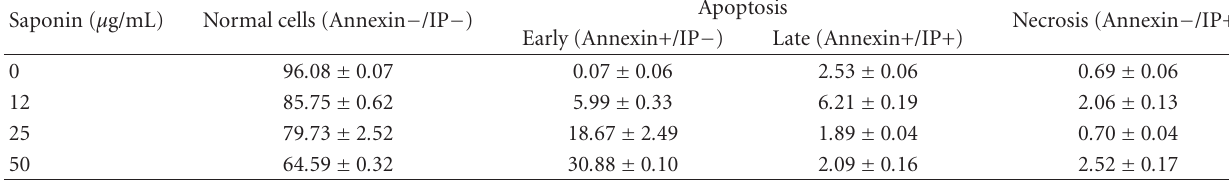
Table 1: Percentage of early and late apoptotic and necrotic CHO-K1 cells following treatment with saponin measured by flow cytometry; mean of three experiments ± SD. IP: propidium iodide.